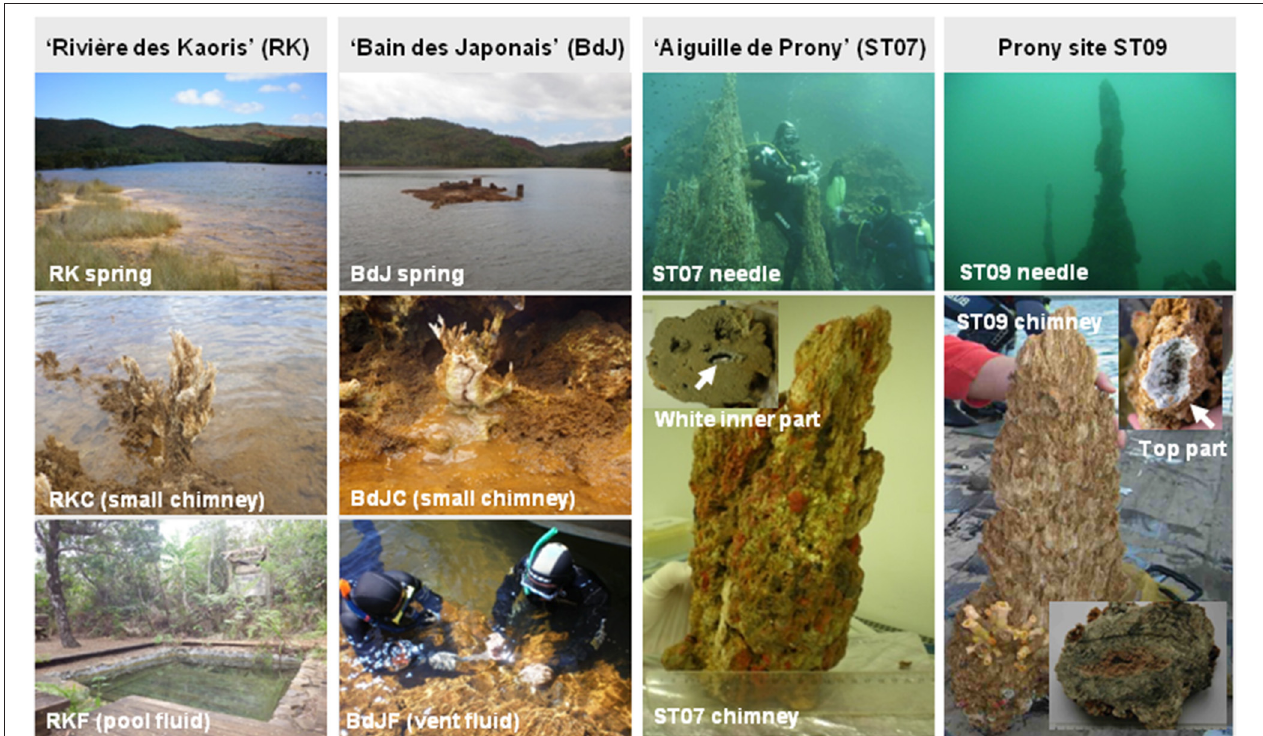
FIGURE 1 | Intertidal and submarine hydrothermal sources of Prony Hydrothermal Field (PHF) in New Caledonia. Photographs show the sampling sites: “Rivière des Kaoris” (RK), “Bain des Japonais” (BdJ), “Aiguille de Prony” (ST07), and the Prony ST09 site. Suffixes “C” and “F” in site names stand, respectively, for chimney and